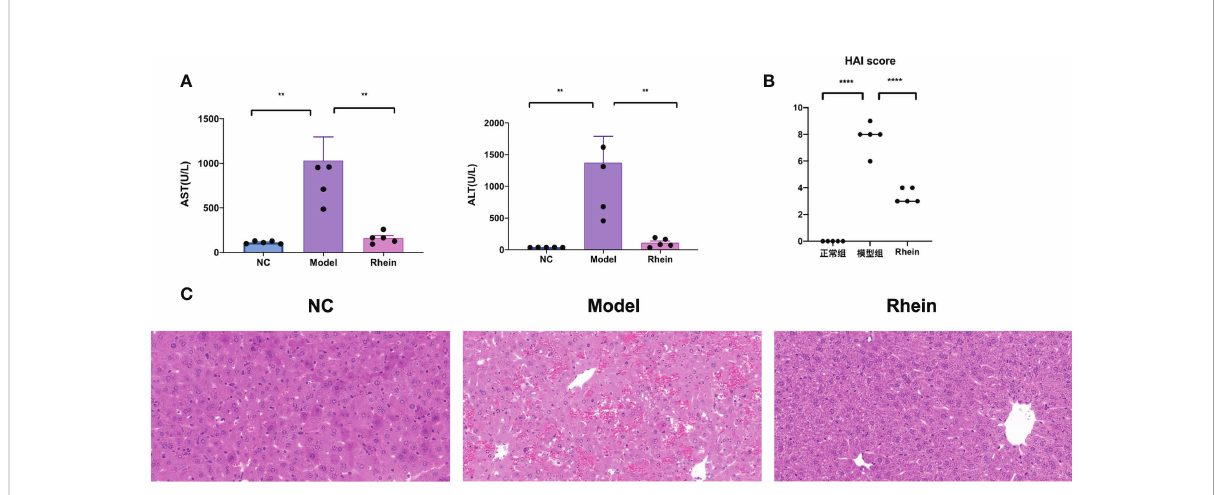
FIGURE 1 Rhein alleviates d-galactosamine/LPS-induced liver injury. (A) Plasma ALT and AST levels were determined 12 hours after intraperitoneal injection of D-GalN/LPS. (B) Liver HAI score. (C) Representative liver sections from different treatment groups (n = 6 each). (**P < 0.01, and ****P < 0.0001 compared to the ALF group, one-way